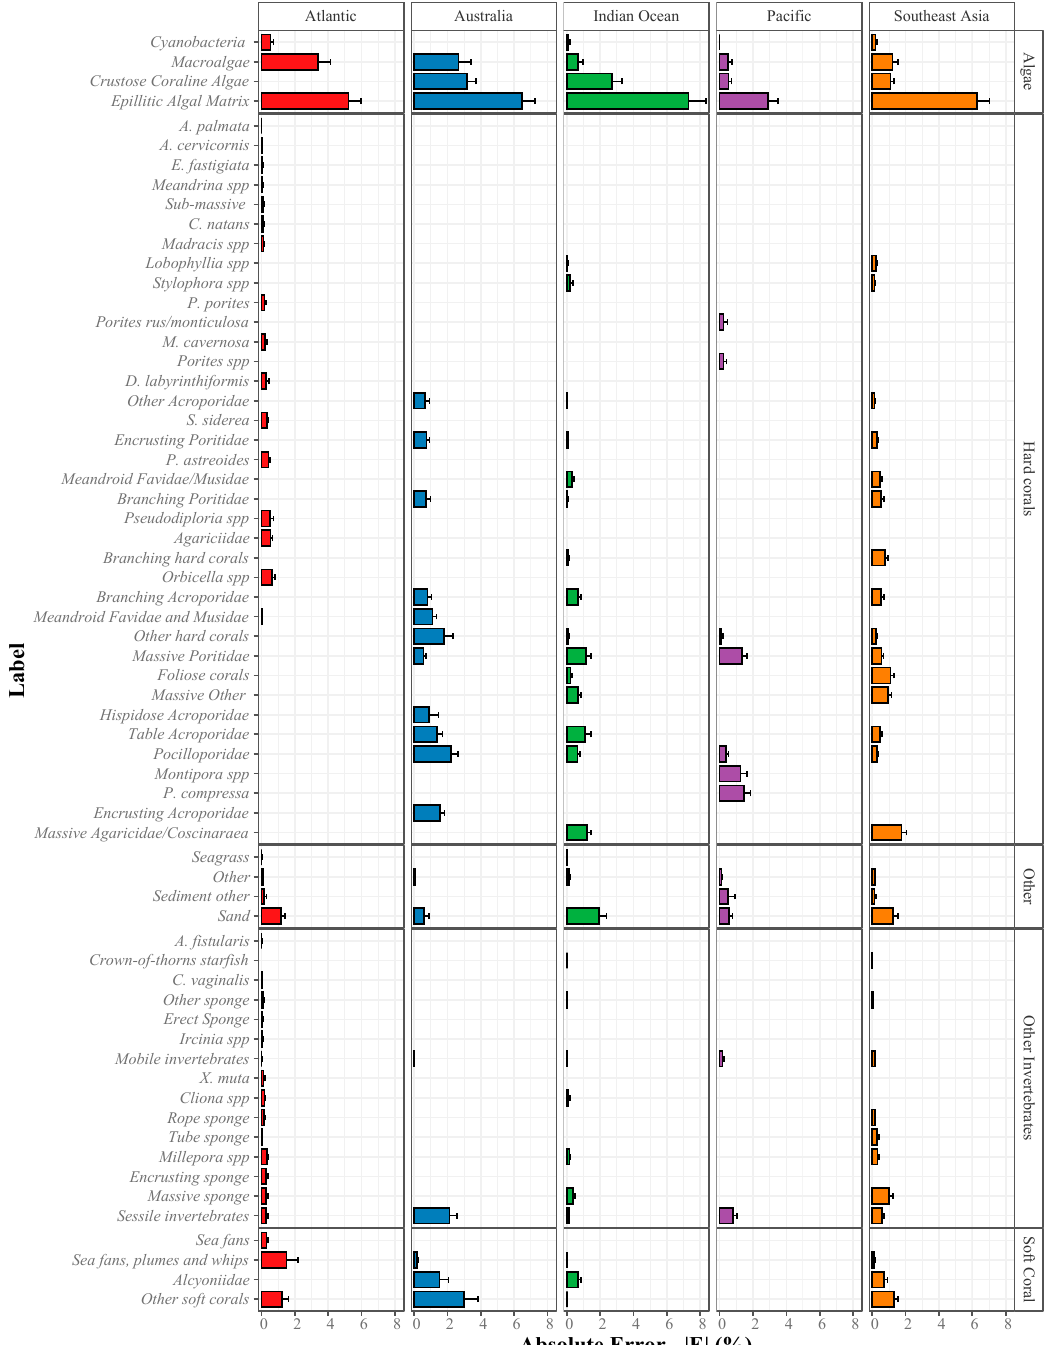
Figure 4. Absolute Error ( | E | ) for the automated estimation of benthic abundance. Errors are aggregated by functional groups, along the y axis, and regions, along the x axis. Solid and error bars represent the mean and 95%-Confidence Intervals of the error, respectively . Across community assemblages within regions, the estimations of benthic composition were between 84% and 94% similar to observer estimations across regions, irrespective of the differences in community structure among and within regions (Figure 5). Across regions, Australia exhibited the lowest values of similarities, 84%, while automated estimations of benthic composition from the Central Pacific Ocean shared 94% similarity with manual observations.